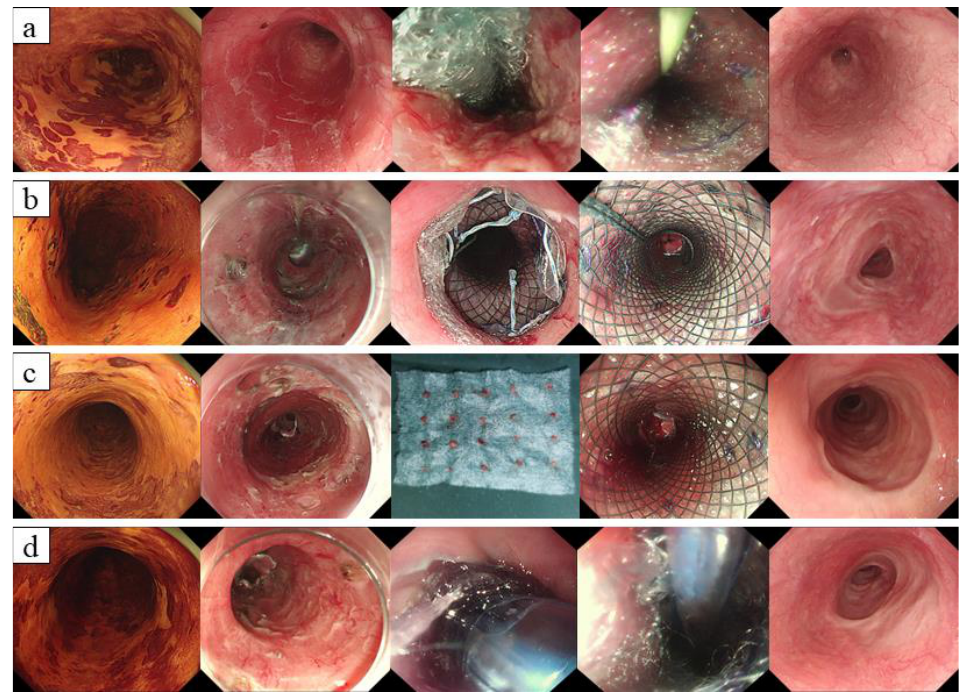
Figure 3. Cases of different methods to prevent esophageal stenosis after treatment. ( a ) PGA with AEM; ( b ) PGA with TSI; ( c ) PGA with AEM transplantation and TSI; ( d ) PGA with AEM transplantation and SSWB. Table 6. Comparison of postoperative stenosis expansion times between different interventions groups.